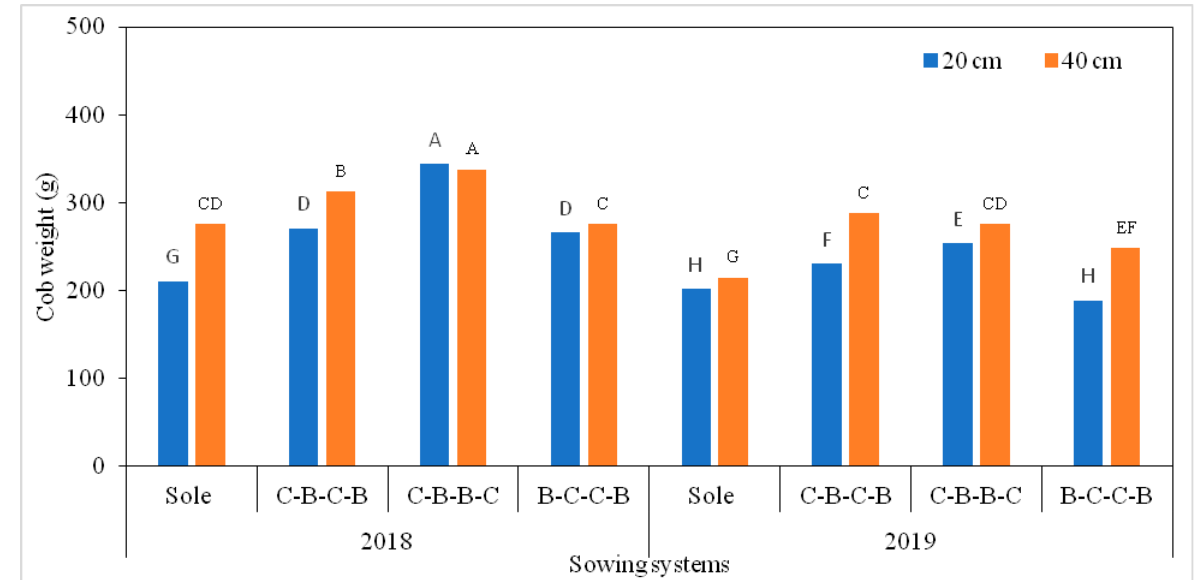
Figure 2. The interactions of maize–white bean sowing systems on cob weight in the Nur Sultan, Kazakhstan study area. Letters on each bar represent a significance level at p < 0.01. Note: different letters denote significant differences, while the same letters indicate insignificantly different values.